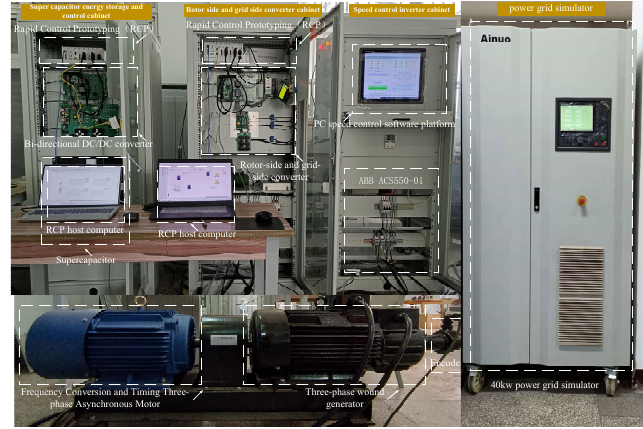
Figure 7. Double ‐ fed induction generator experiment platform. Figure 7. Double-fed induction generator experiment platform. Table 2. The change in rotor speed at a given power at a wind speed of 7 m/s.